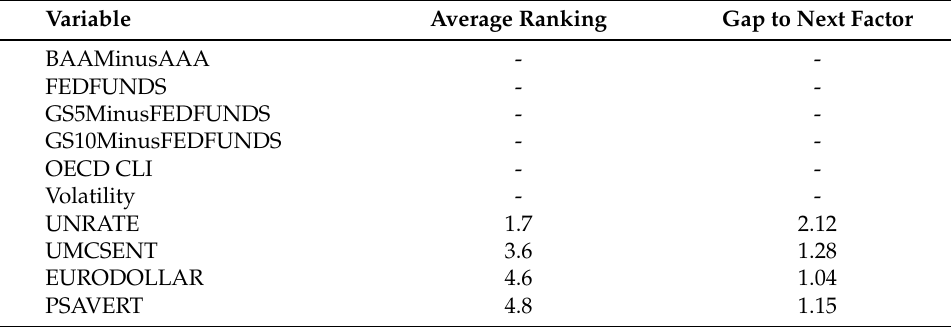
Table 3. Input factors from [15] in S initially (Model